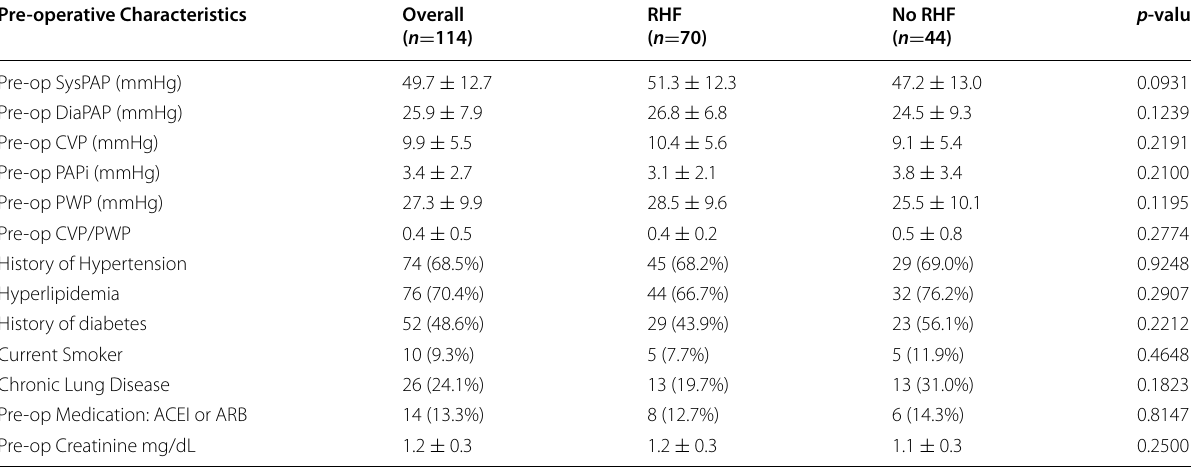
* p ‑values comparing patients with right heart failure vs no right heart failure. **For continuous variables mean square test. PAP pulmonary arterial pressure, CVP central venous pressure, PAPi pulmonary artery pulsatility index, PWP pulmonary wedge pressure, ACEI angiotensin‑ converting enzyme inhibitors, ARB angiotensin receptor blocker